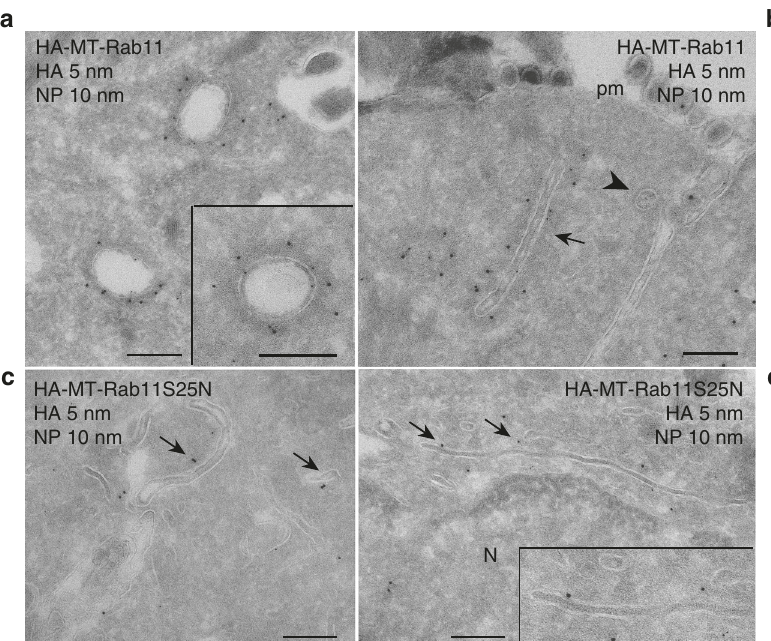
Fig. 7 Rab11 co-localizes with NP on ICVs and is required for ICV formation. A549 cells expressing HA-MT-Rab11 a , b or HA-MT-Rab11-S25N c , d were infected with the WSN virus and fi xed for immuno-EM at 16 hpi. Thawed cryosections were labeled for HA (5 nm gold) and NP (10 nm gold). a Two ICVs in the cytoplasm that are positive for both NP and Rab11. The insert shows in detail an ICV with the characteristic irregular electron dense coat and label for Rab11 and NP. b An area underneath the plasma membrane (pm) with viral particles outside the cell and a tubular ICV (arrow) close to it. Label for Rab11 and NP are found on the ICV. The irregular electron dense coat of the ICV can be clearly distinguished against the regular coat of clathrin, present on a clathrin-coated pit (arrowhead). c , d In cells expressing HA-MT-Rab11-S25N ICVs are absent. Instead, NP labeling is present on small vesicles and tubules (arrows). These tubules show no visible coat but often have an electron dense lumen. Scale bars, 200